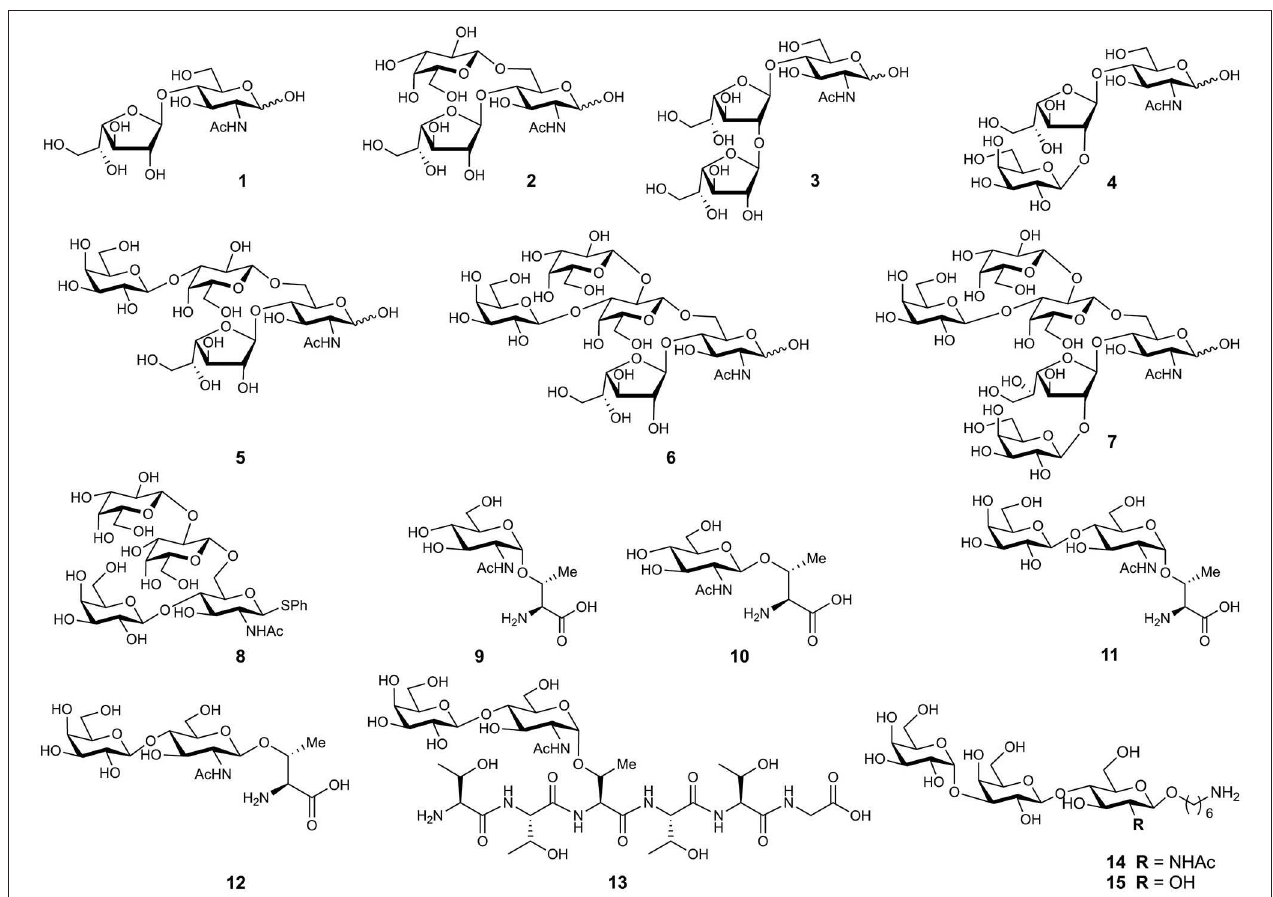
FIGURE 4 | Chemical structure of synthesized glycans from MLMs of Trypanosoma cruzi Colombiana strain ( 1 , 2 , 6 , 7 ), Tulahuen strain ( 3 – 5 ), and Y strain ( 8 – 13 ).